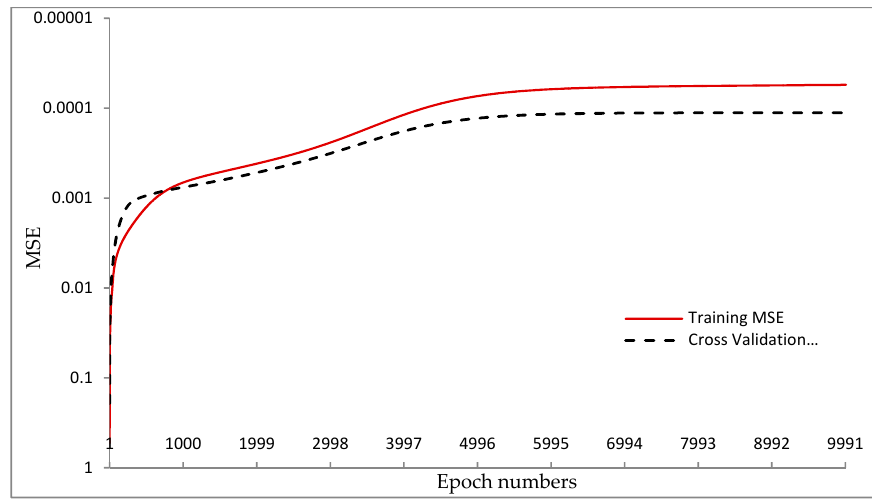
Figure 11. The testing of MSE for the proposed SOFM model using 5000 epochs.